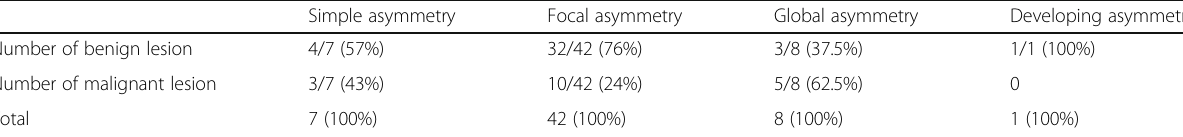
Table 2 Distribution of benign and malignant lesions within the different types of asymmetries Simple asymmetry Focal asymmetry Global asymmetry